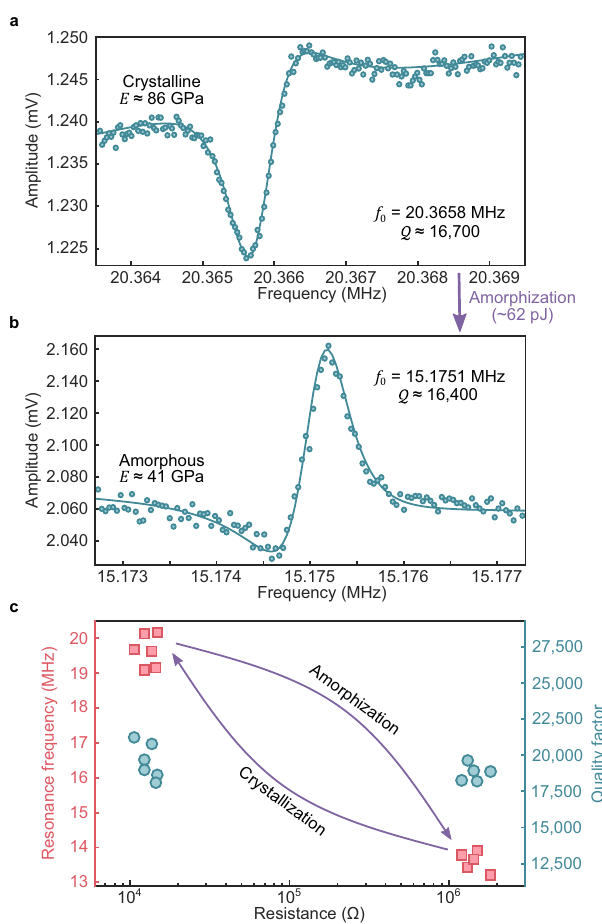
Fig. 2 Electrical testing and tuning of the phase-change nanowire. a Frequency response of a 7 μ m-long virgin nanowire ( R = 1.15 k Ω ). The plot shows the raw measurement data (dots, 10 averages, 100 Hz bandwidth) for a drive voltage V drive = 450 mV. The Lorentzian fi t with a linear background (solid line) yields f cry = 20.3658 MHz and Q ≈ 16,700. Young ’ s modulus in the crystalline state is E cry ≈ 86 GPa. b Raw data (dots, 10 averages, 100 Hz bandwidth) of the amorphized nanowire ( R = 0.16 M Ω ) after a 1.2 V – 50 ns electrical pulse, for the same drive level. The fi t (solid line) suggests the resonance frequency is tuned down to f = 15.1751MHz while the quality factor remains almost the same amo ( Q ≈ 16,400). The effective Young ’ s modulus in an amorphous state is estimated as E amo ≈ 41 GPa. c Cyclability test of another 7 μ m-long nanowires. The scatter plot shows the resonance frequency (red squares, left-axis) and the quality factor (green circles, right-axis) of another 7 μ m- long nanowires versus its electrical resistance for many tuning cycles (3.5 V – 50 ns pulses for amorphization and Joule annealing at 1 μ A for crystallization). The mean resonance frequency ratio between two phases = (cid:1) f = 1.45, and the Q (19,210 ± 1034) shows no dependence on is (cid:1) f cry amo